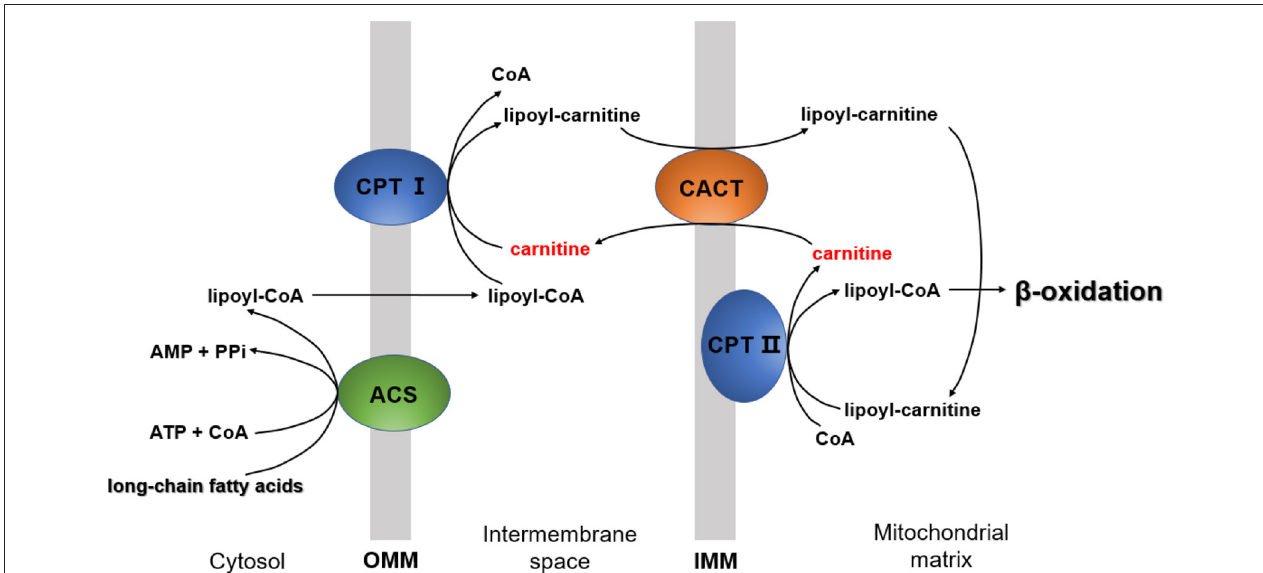
FIGURE 2 | The mechanism by which long-chain fatty acids enter the mitochondria. CPT I, carnitine palmitoyltransferase I; CPT II, carnitine palmitoyltransferase II; ACS, acyl-CoA synthetase; CACT, carnitine-acylcarnitine translocase; OMM, outer mitochondrial membrane; IMM, inner mitochondrial membrane.